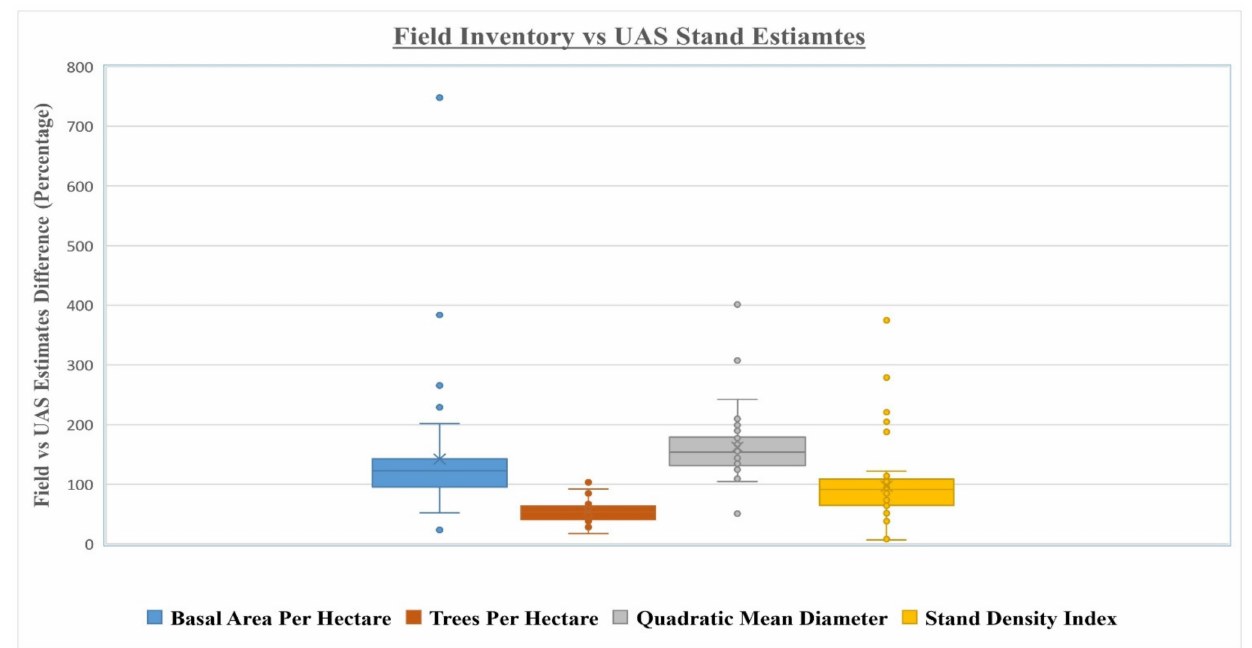
Figure 4. Comparison of field-based inventory estimates and UAS-based inventory estimates of stand level characteristics including: Basal Area per Hectare (BA/ha), Trees per Hectare (TPH), Quadratic Mean Diameter (QMD), and Stand Density Index (SDI). Table 5. Thematic accuracy error matrices for the classification of large trees. ( A ) Using the linear regression equation for dbh based on the segmented crown radius and ( B ) using a random forest supervised classification. A: Linear Regression: Large